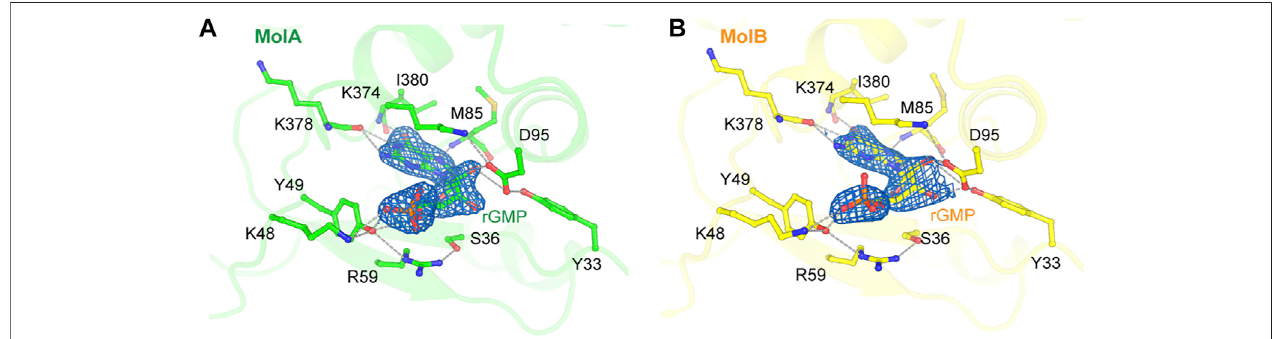
FIGURE4| NucleotidebindingsiteintheN-terminaldomainsofMolA (A) andMolB (B) .The σ A -weighted 2 F obs - F calc electron densitymapsarecontoured at1.5 σ . Hydrogen bonds are displayed as dashed lines.